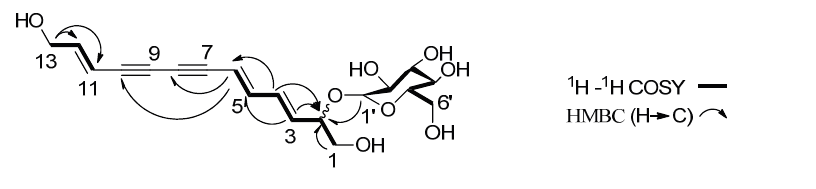
Figure 1. Key 1 H- 1 H COSY and HMBC (H → C) correlations of compound 1